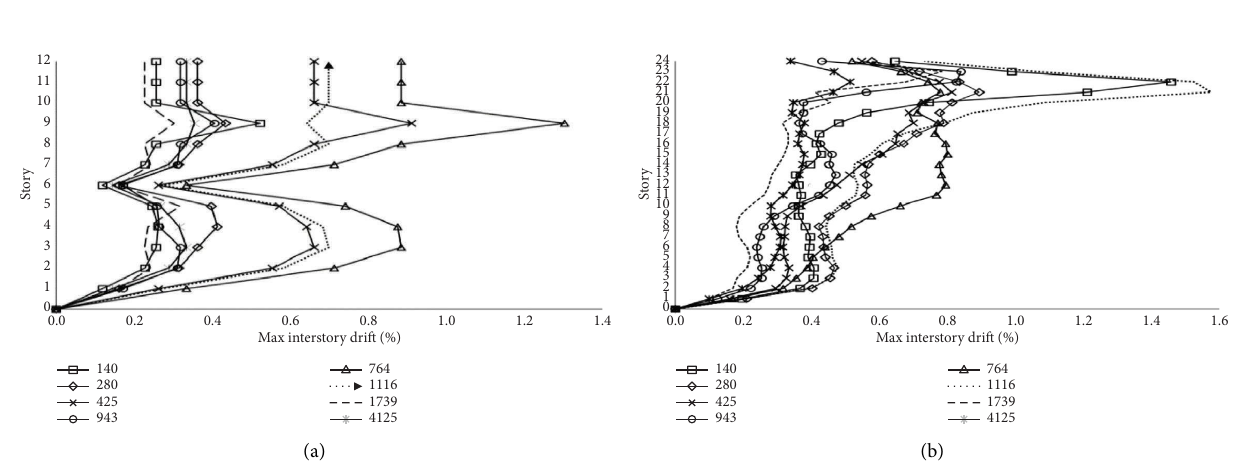
Figure 12: Peak maximum interstory drift of stories under artifcial earthquake: (a) 12-story model. (b) 24-story